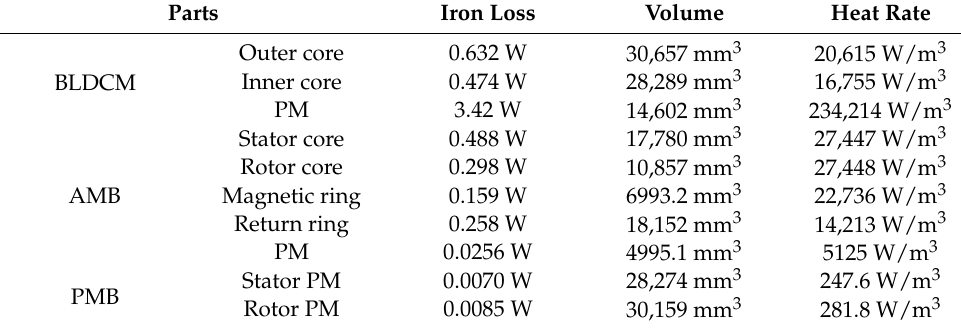
Table 10. Heat rate of the iron loss in the